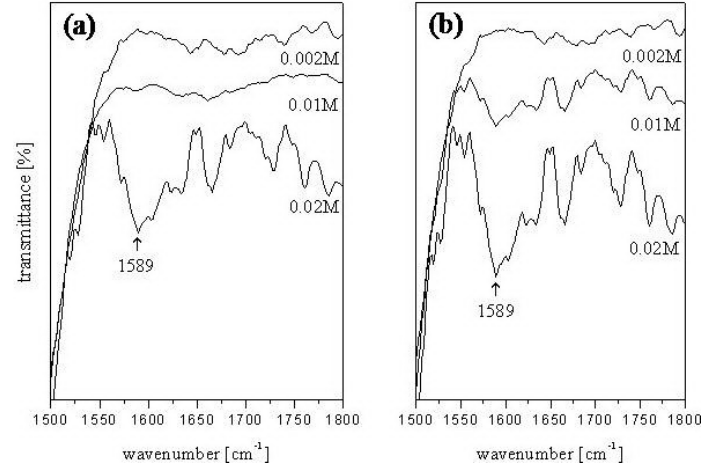
Figure 3. ATR-FTIR spectrums showing the carbonate stretching between 1,500 and 1,800 cm -1 . From the top spectrum, the initial concentration of amino acid solution is 0.002, 0.01 and 0.02 M. (a) Calcite reacted with L -asp solutions and (b) reacted with L -glu